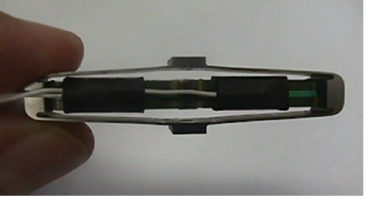
Figure 4. Piezoelectric actuator, APA400M, from Adaptronics, Inc.